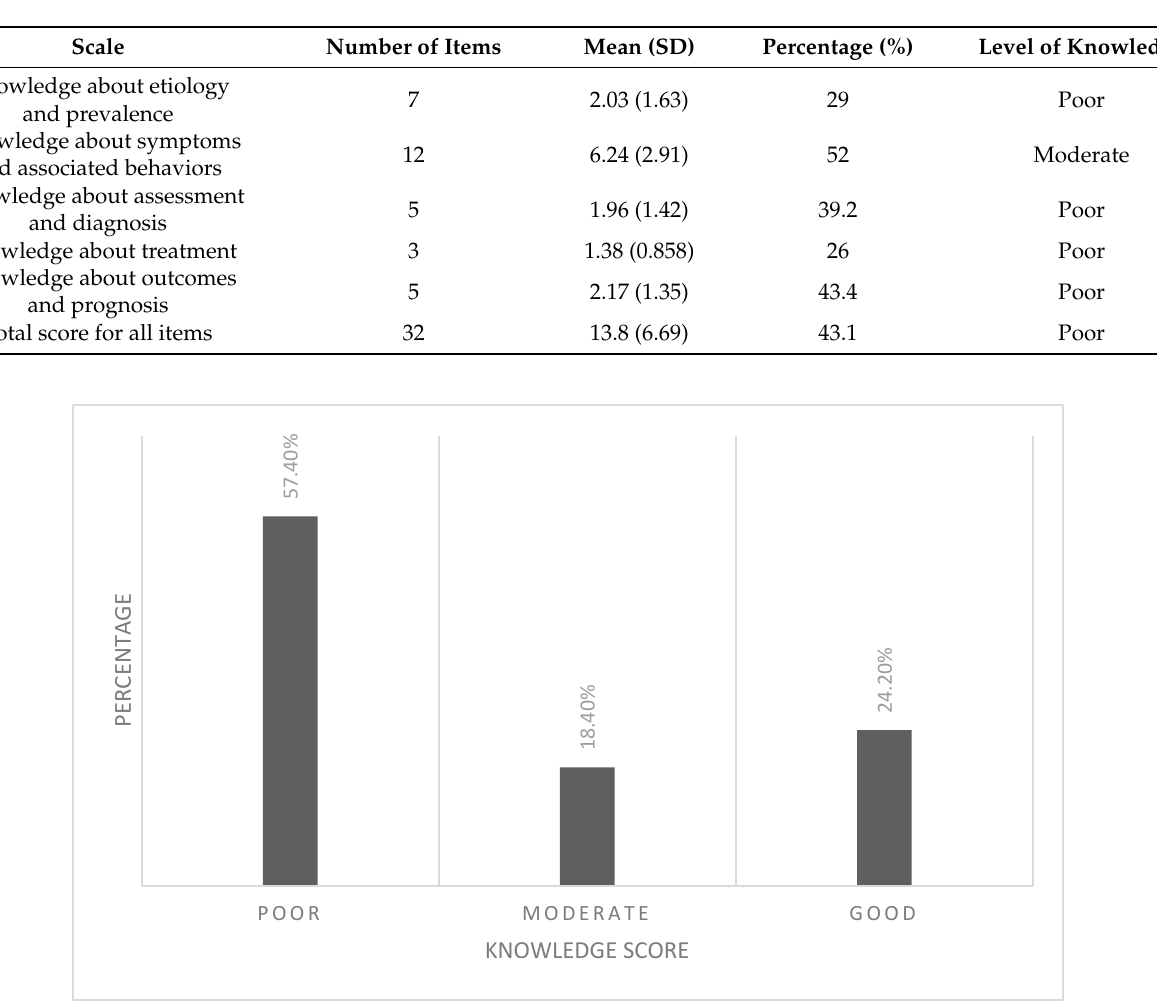
Table 6. Comparison of knowledge scores according to socio-demographic variables.